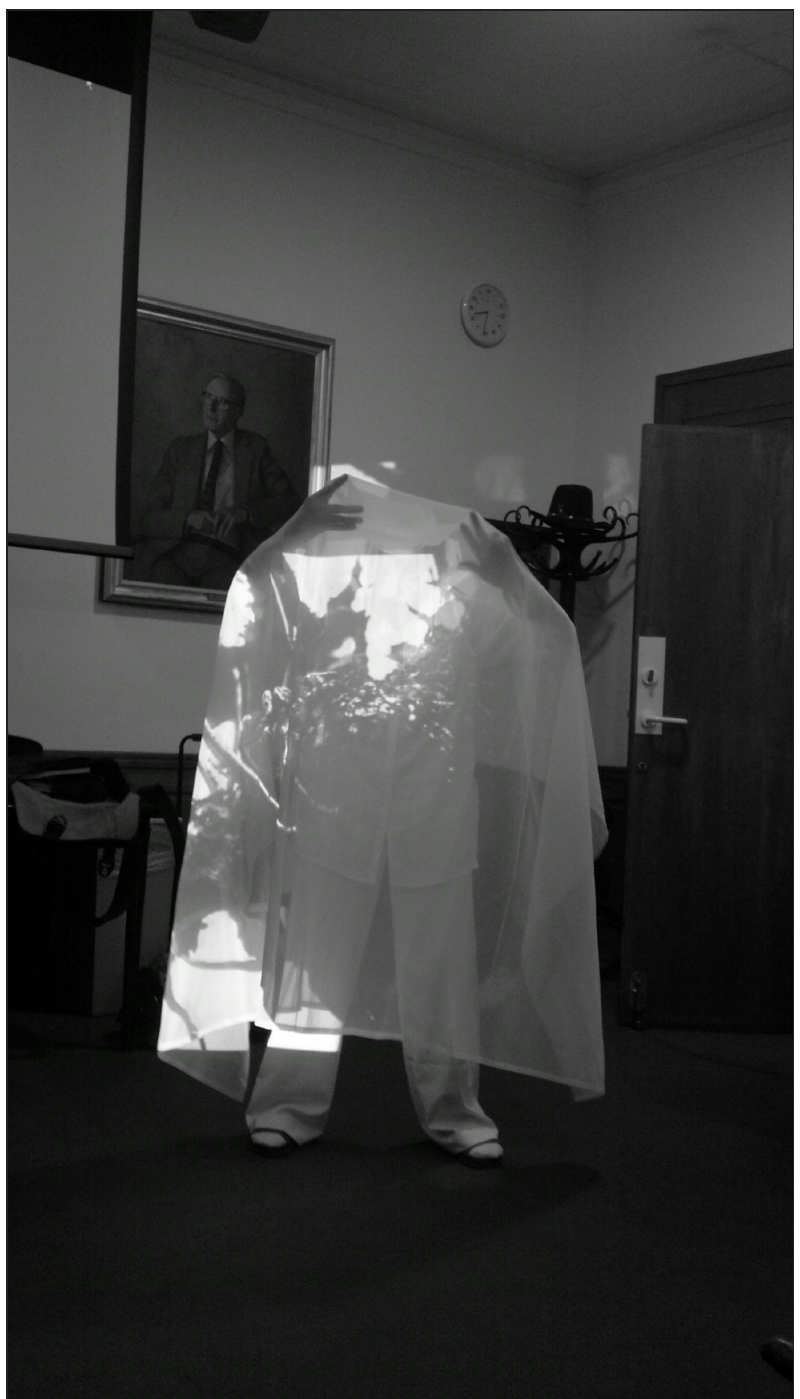
Figure 3.2: Jennifer Pike at Birkbeck College, University of London, 2011. Courtesy of